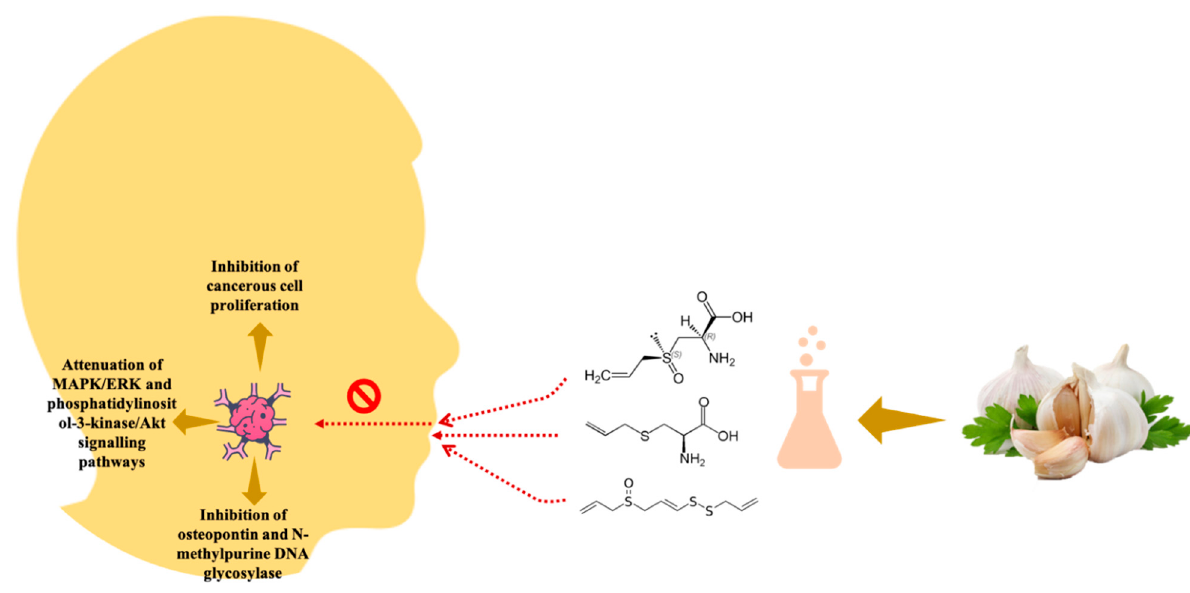
Figure 5. Anticancer activity of GE.